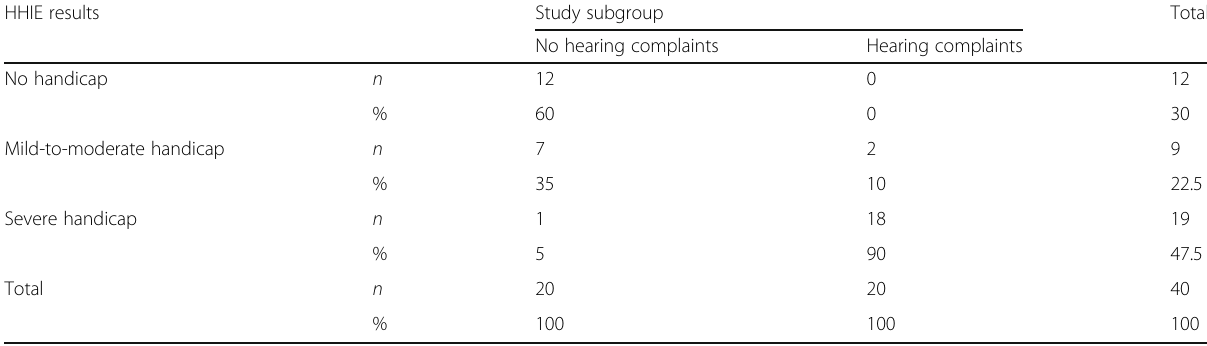
Pearson chi-square=29.988, p